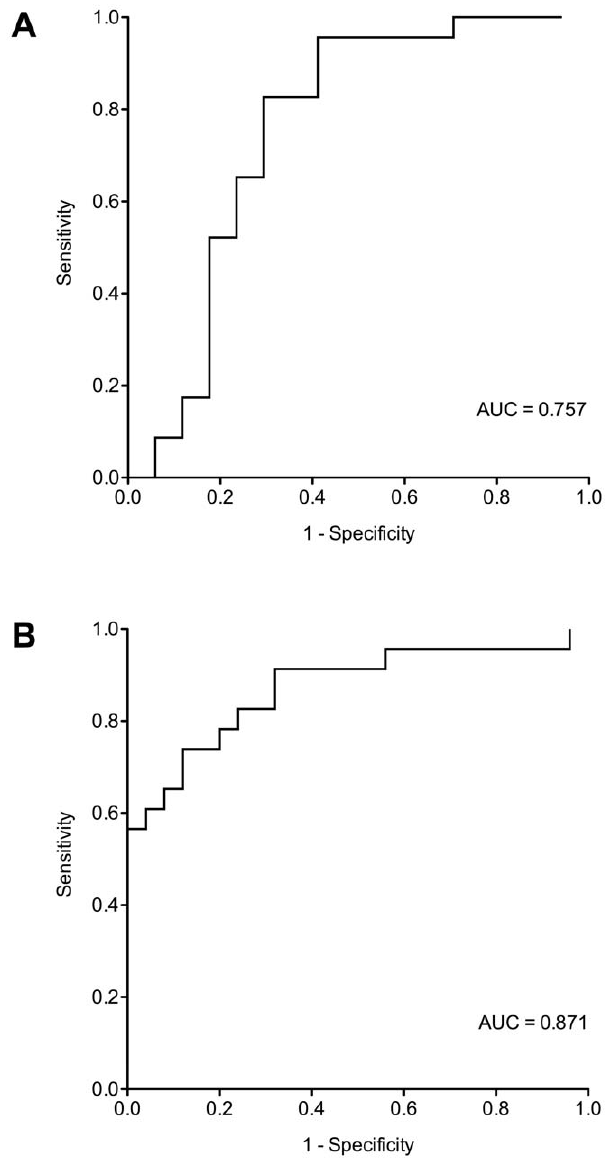
Figure 5. Receiver operating characteristics (ROC) curves of miR-103. The area under curve (AUC) was determined for miR-103 in the cellular fraction of human peripheral blood of (A) malignant mesothelioma patients and asbestos-exposed controls and (B) malig- nant mesothelioma patients and controls from the general population.